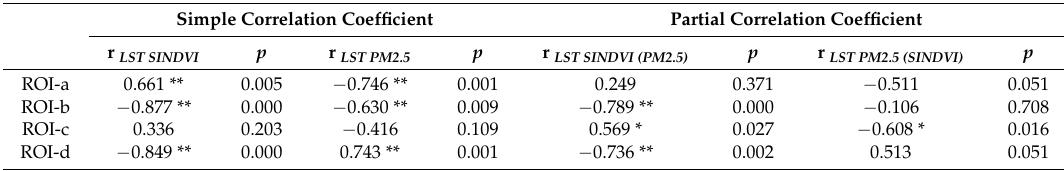
Table 3. Statistical analysis of relation between LST with SINDVI and PM 2.5 in the regions of interest (ROIs). Simple Correlation Coefficient Partial Correlation